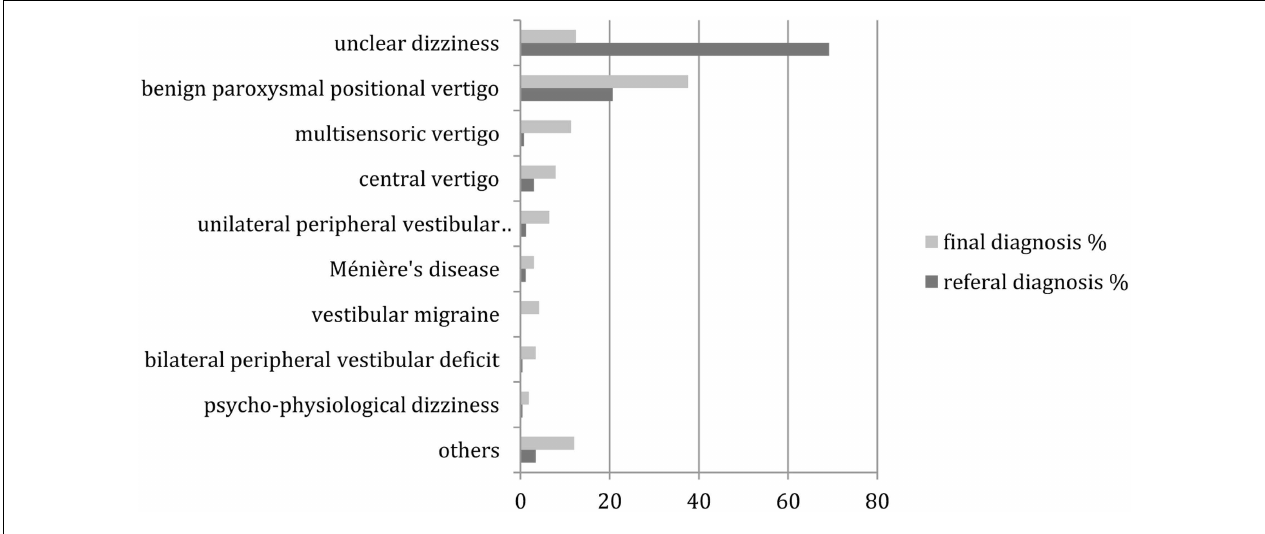
FIGURE 3 | Distribution of referral and final diagnoses in patients aged 65years and above. “Others” include presyncopal dizziness, perilymph fistula, ocular vertigo, afferent ataxia, dizziness after head trauma, vestibular